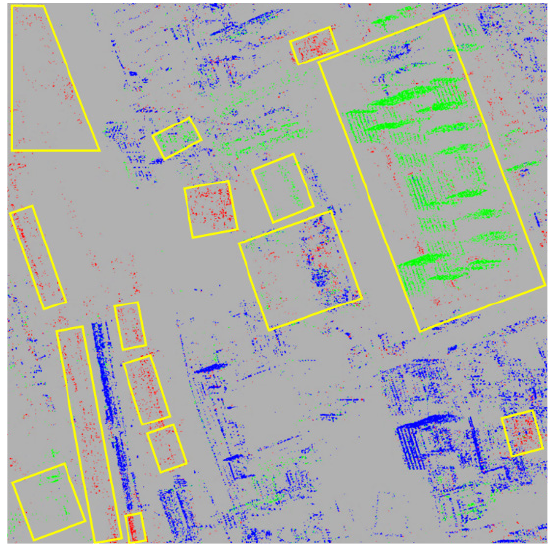
Figure 8. Amplitude-based semi-PS result. Steady, disappearing, and emerging structures represented by PS (blue), DBC (red), and EBC (green) points. Yellow square, building